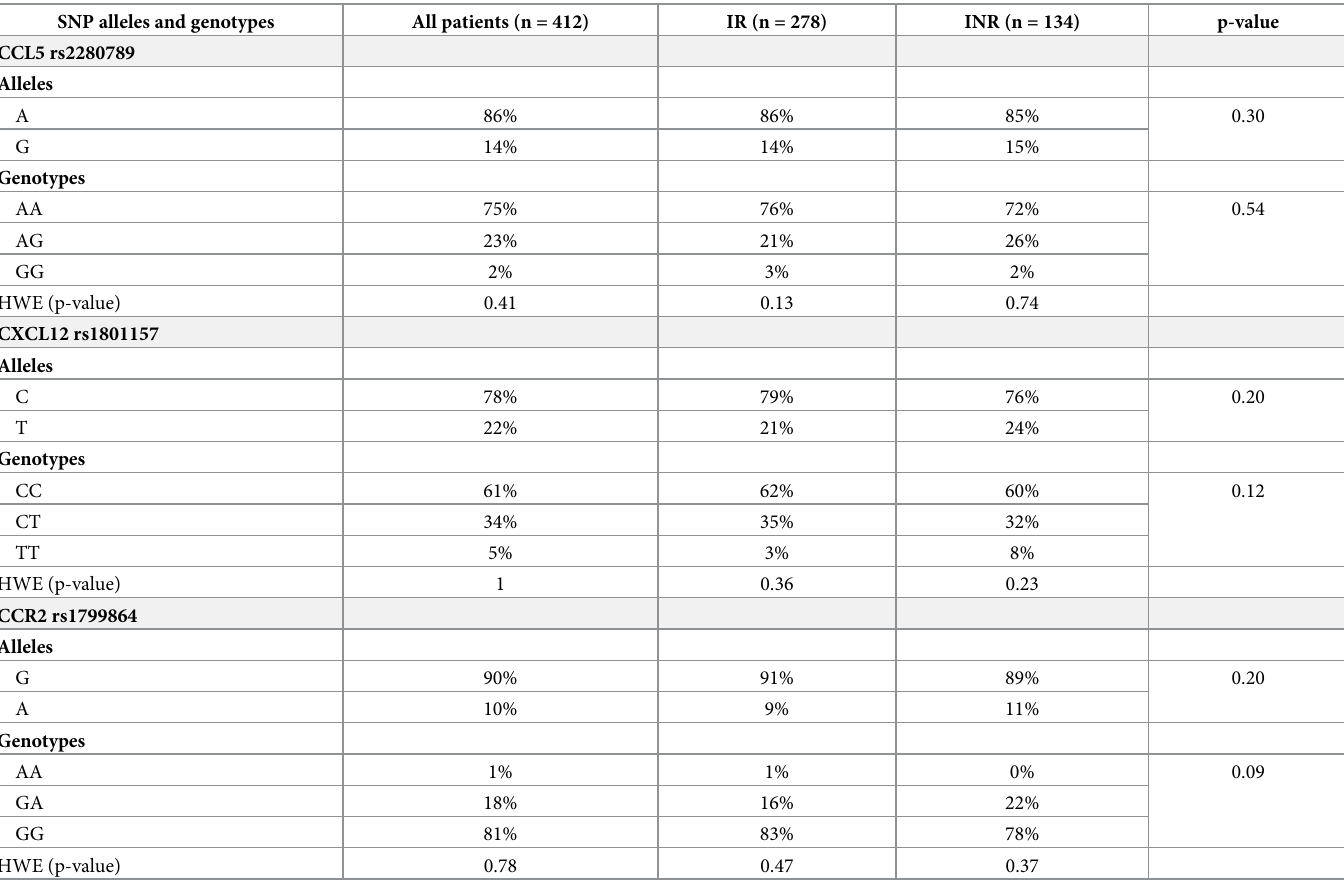
Table 2. Summary of alleles and genotype frequencies for CCL5 rs2280789, CCR2 rs1799864 and CXCL12 rs1801157 polymorphims in the study population. SNP alleles and genotypes